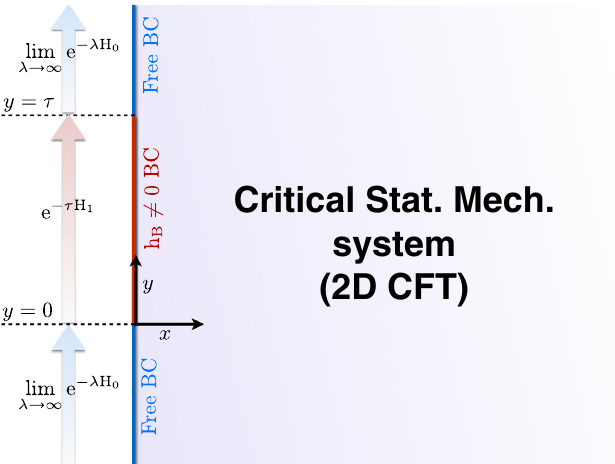
τ Þ of the 2D ; 1 ð